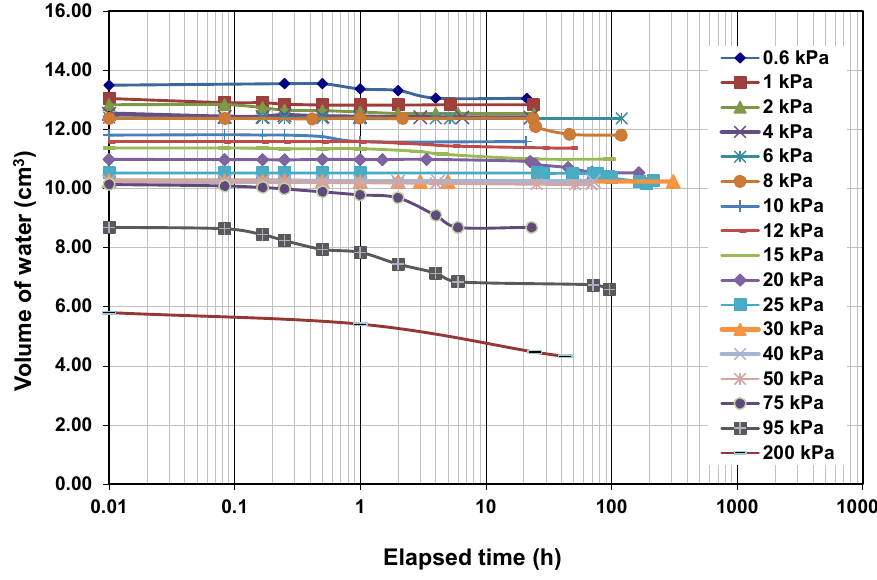
Figure 4. Equalization time of soil specimen 70S30K.